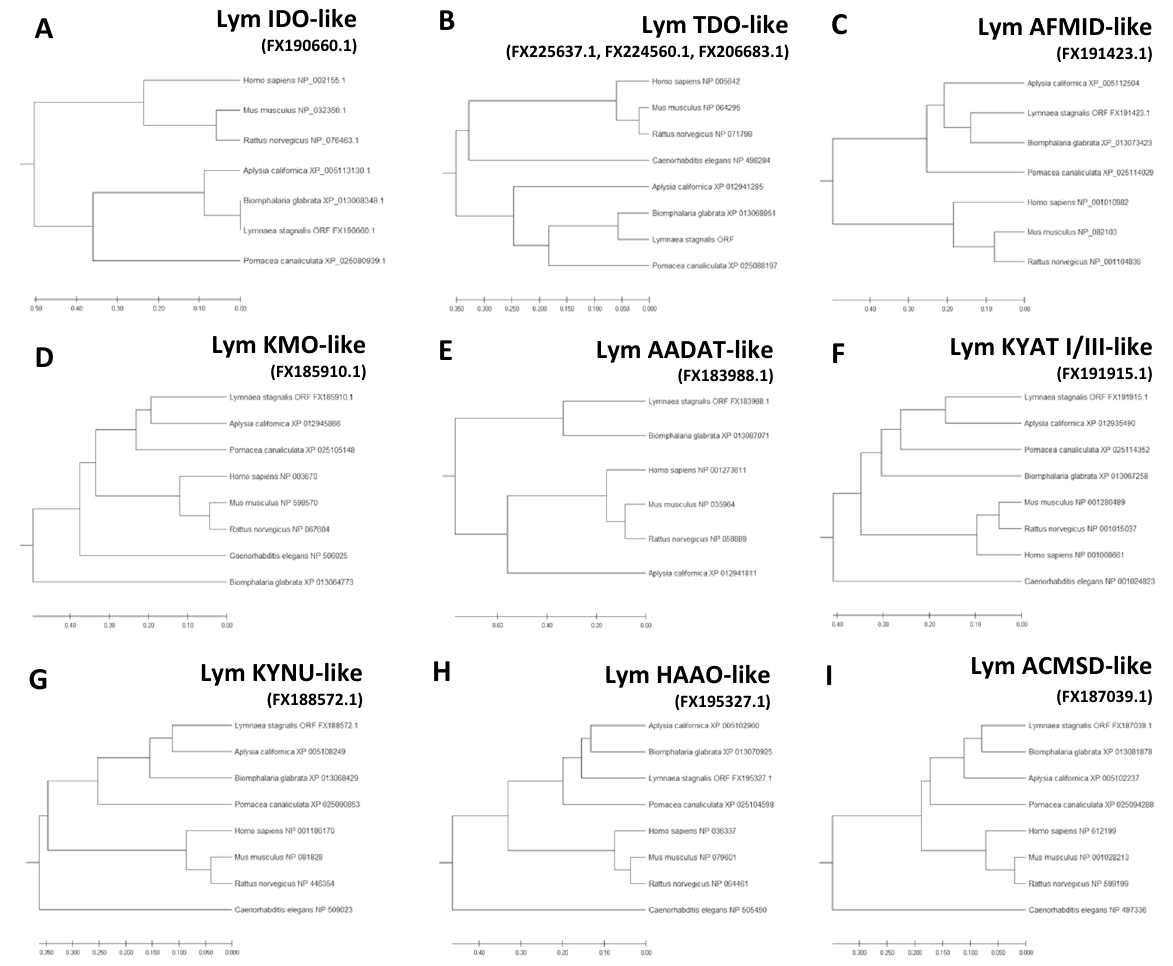
Figure 4. Molecular phylogenetic tree of the putative KP enzymes in L. stagnalis . ( A ) Lym IDO-like, ( B ) Lym TDO-like, ( C ) Lym AFMID-like, ( D ) Lym KMO-like, ( E ) Lym AADAT-like, ( F ) Lym KYAT I/III-like, ( G ) Lym KYNU-like, ( H ) Lym HAAO-like, ( I ) Lym ACMSD-like. The tree is drawn to scale, with branch lengths in the same units as the evolutionary distances used to infer the phylogenetic tree. The evolutionary distances were computed using the Poisson correction method and are in the units of the number of amino acid substitutions per site. This analysis involved 7–8 amino acid sequences. Evolutionary analyses were conducted in MEGA X. The GenBank accession numbers of proteins used are indicated and listed in Table